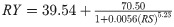
Relationship between relative cultivar seed yield (RY, %) and relative cultivar phoma stem canker severity (RS, %).The relationship was fitted (broken short line) by the logistic equation (RY=39.54+70.501+0.0056(RS)5.23) using the data from winter oilseed rape field experiments at 13 sites (see Table 1) in three growing seasons (2010/2011, 2011/2012, 2012/2013).